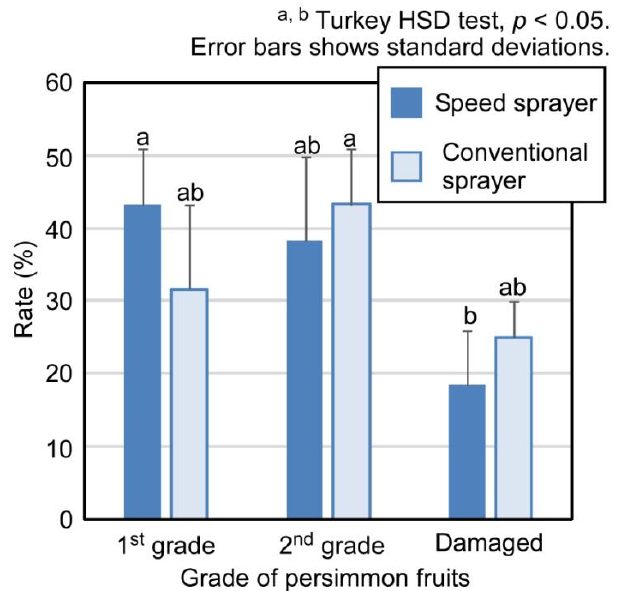
Figure 6. Quality change in persimmon fruits when using the Speed Sprayer (SS) and conventional sprayer.